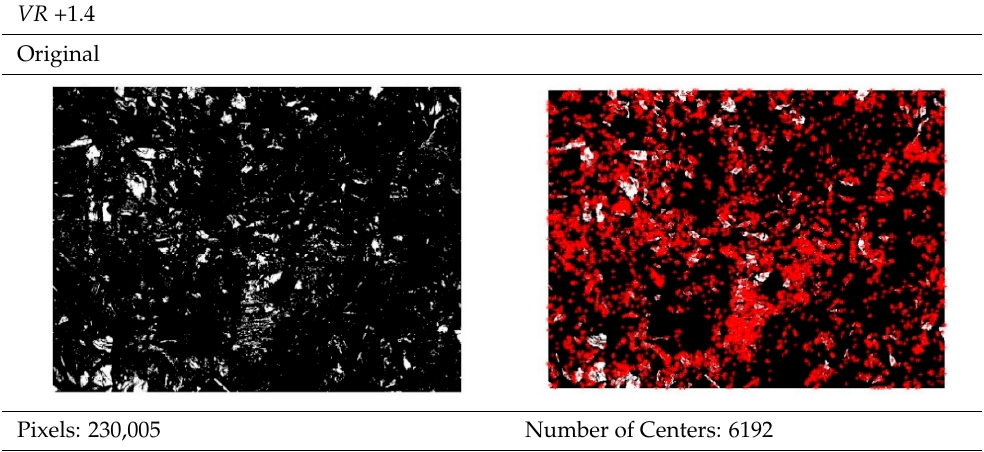
Table A5 . Images and associated pixels and number of centers corresponding to VR = +1.4. VR +1.4